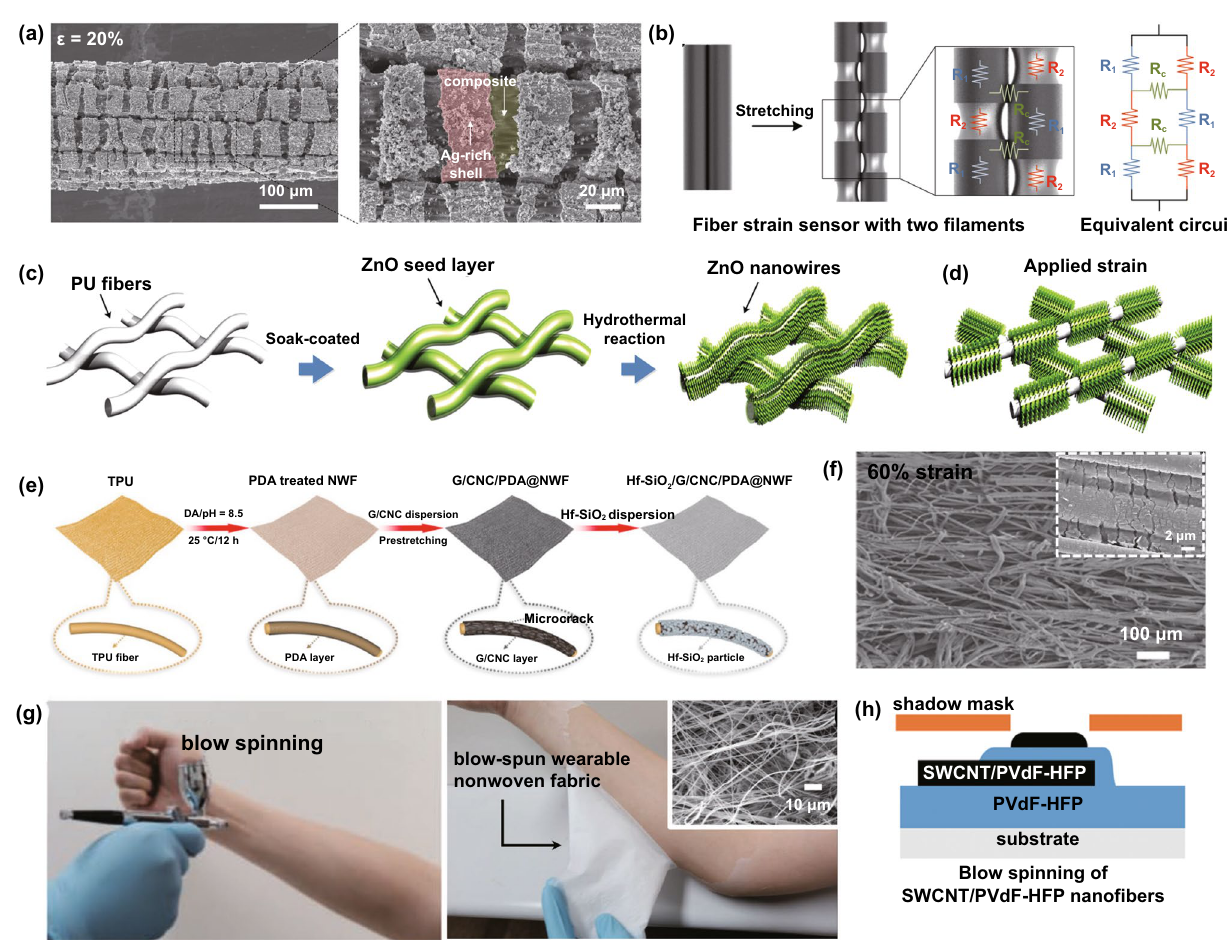
Fig. 6 a A yarn-like strain sensor fabricated by modifying PU yarn with AgNPs, and b the corresponding mechanism of the sensor [123]. Copy- right © 2018 American Chemical Society. c The fabrication of a strain sensor by modifying PU fiber with ZnO NWs through the layer-by-layer coating, and d the crack formation on the sensor to show the sensing mechanism [114]. Copyright © 2016 Wiley-VCH. e The fabrication of a tunable wearable strain sensor with self-cleaning capability by layer-by-layer multifunctional coating, and f the crack formation of the coating layer to show the sensing mechanism [138]. Copyright © 2019 Elsevier. g The fabrication of nonwoven fabrics through blow spinning, and h the fabrication of a capacitive strain sensor by vertically stacking the PVdF-HFP dielectric fabric and the CNT/PVdF-HFP conductive fabric